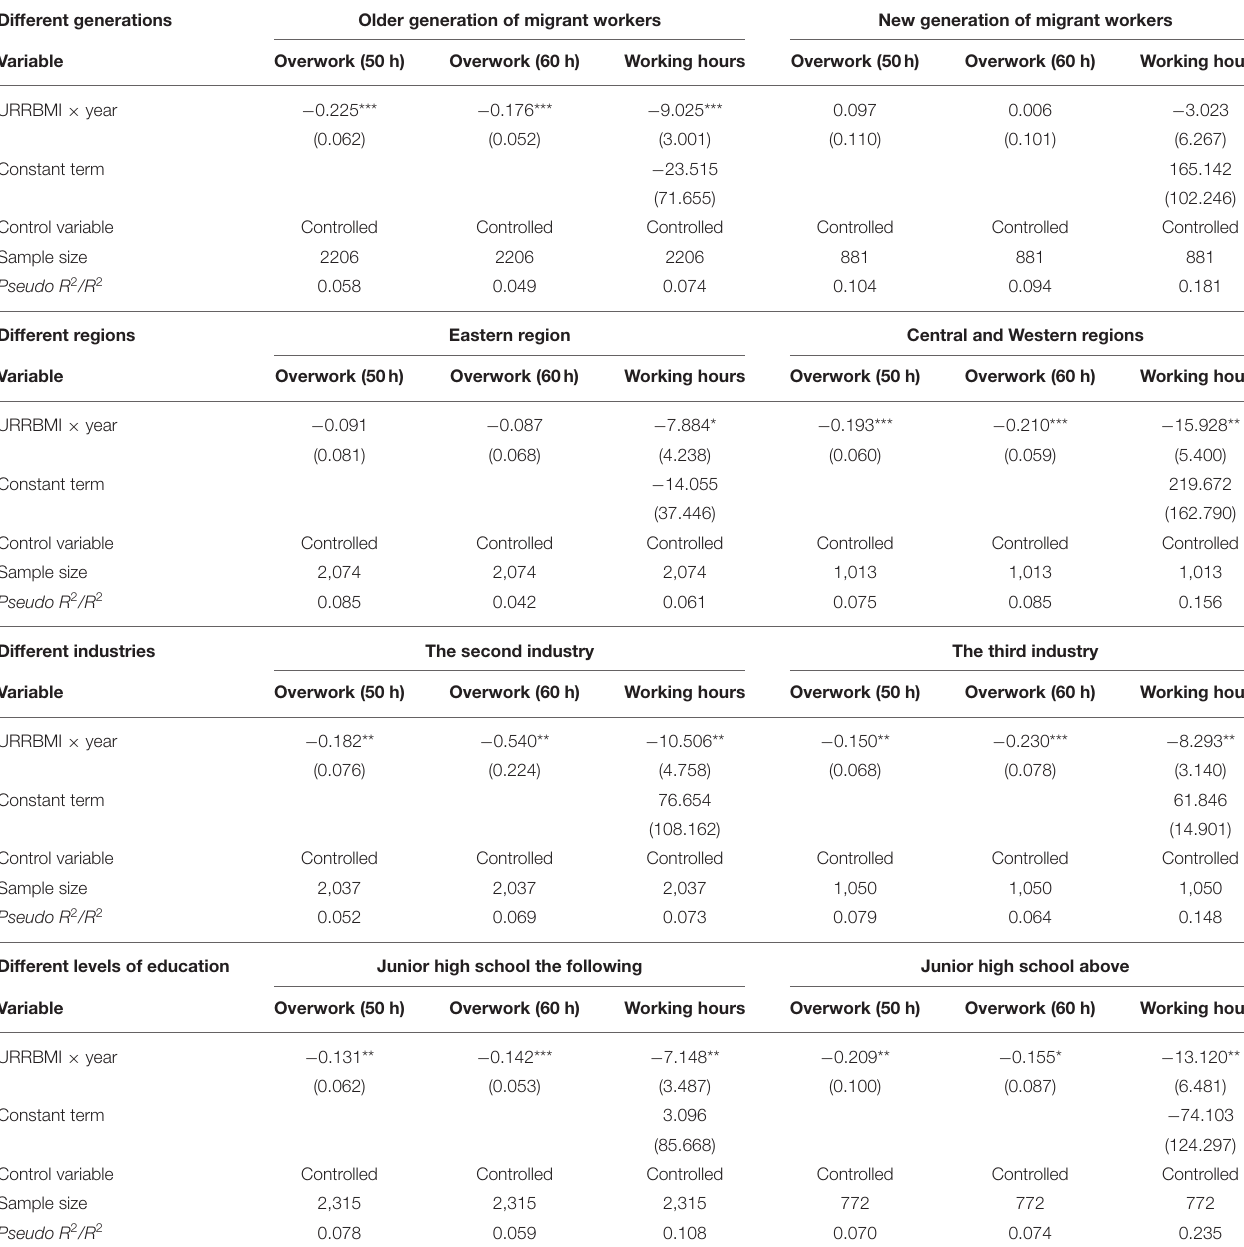
TABLE 6 | Heterogeneity